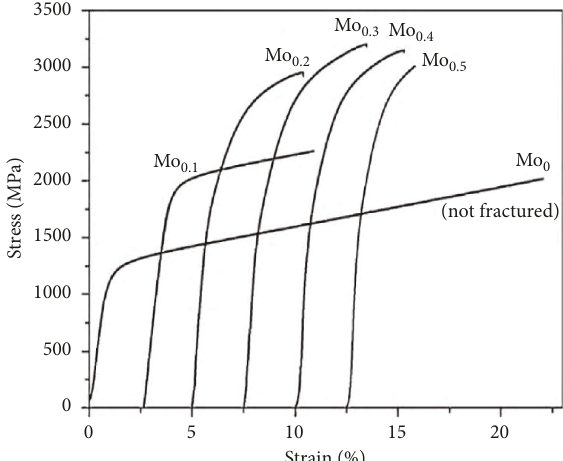
Figure 6: Stress–strain curves of as-cast AlCoCrFeNiMo 0.5) HEA [26].